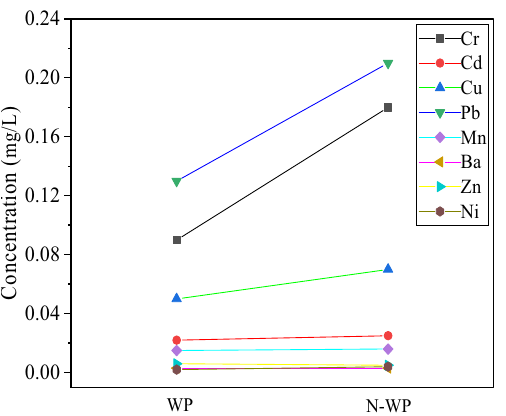
Figure 8. Influence of MSWI fly ash washing pretreatment on heavy metal leaching of